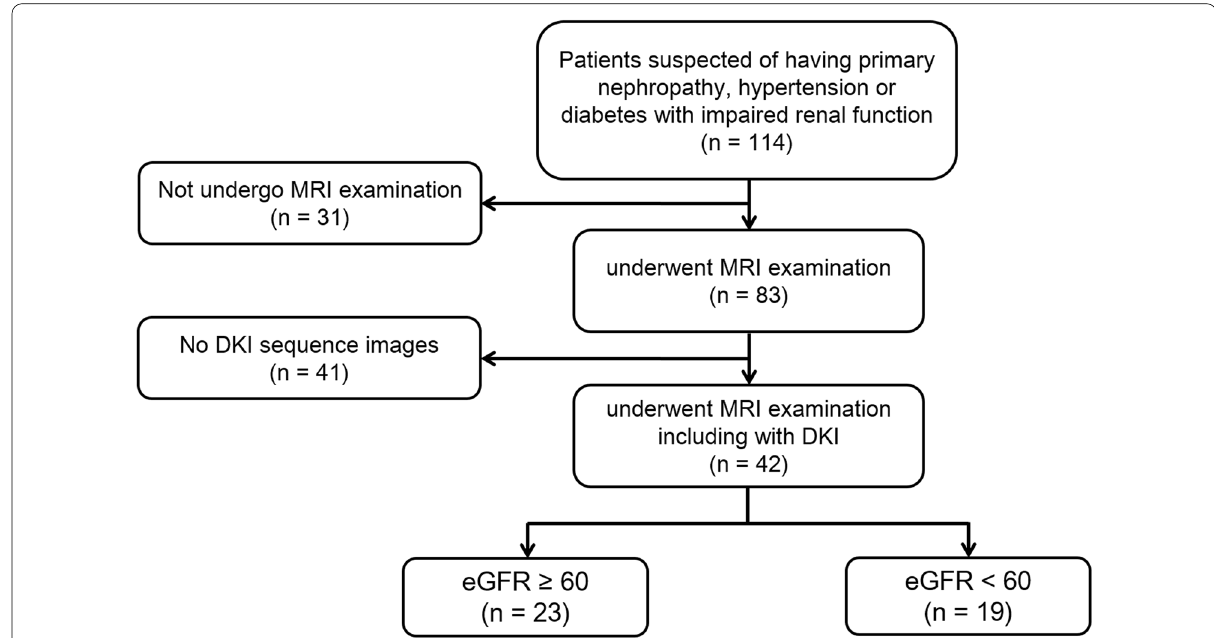
Fig. 1 The flow chart of study